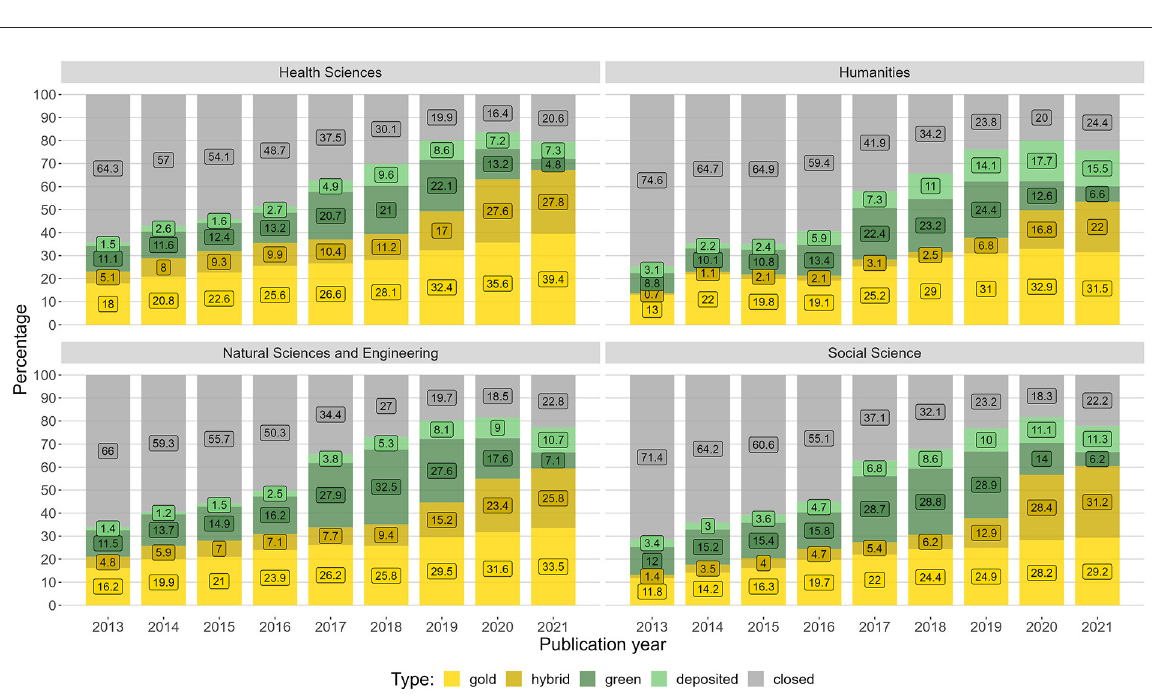
expired, the share of deposited articles after 2017 is quite large, pointing to an unrealized potential for green open access even in the case articles are deposited. The potential of the